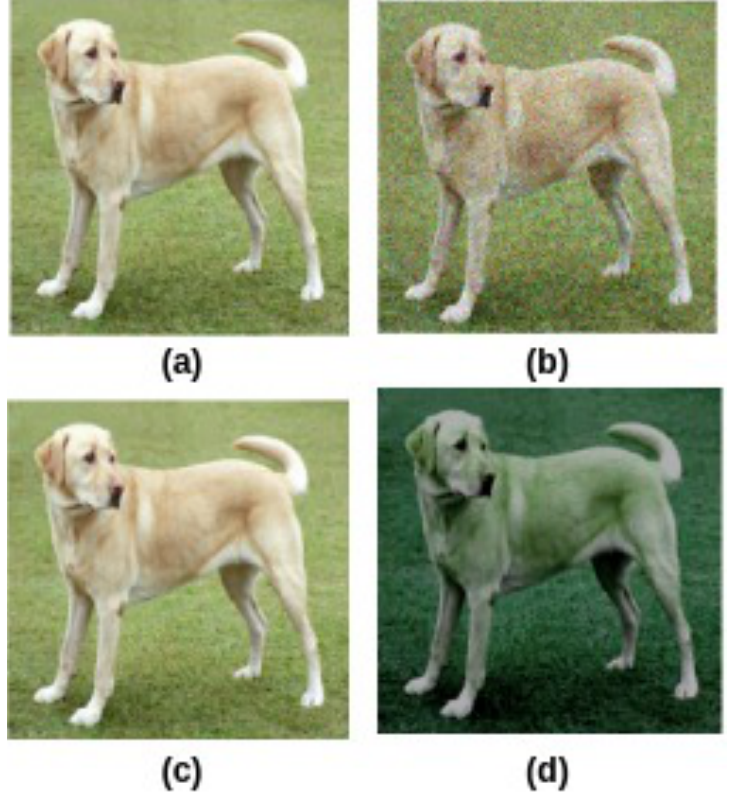
Figure 4. Color Transformation as pretext task [15]. ( a ) Original. ( b ) Gaussian noise. ( c ) Gaussian blur. ( d ) Color distortion